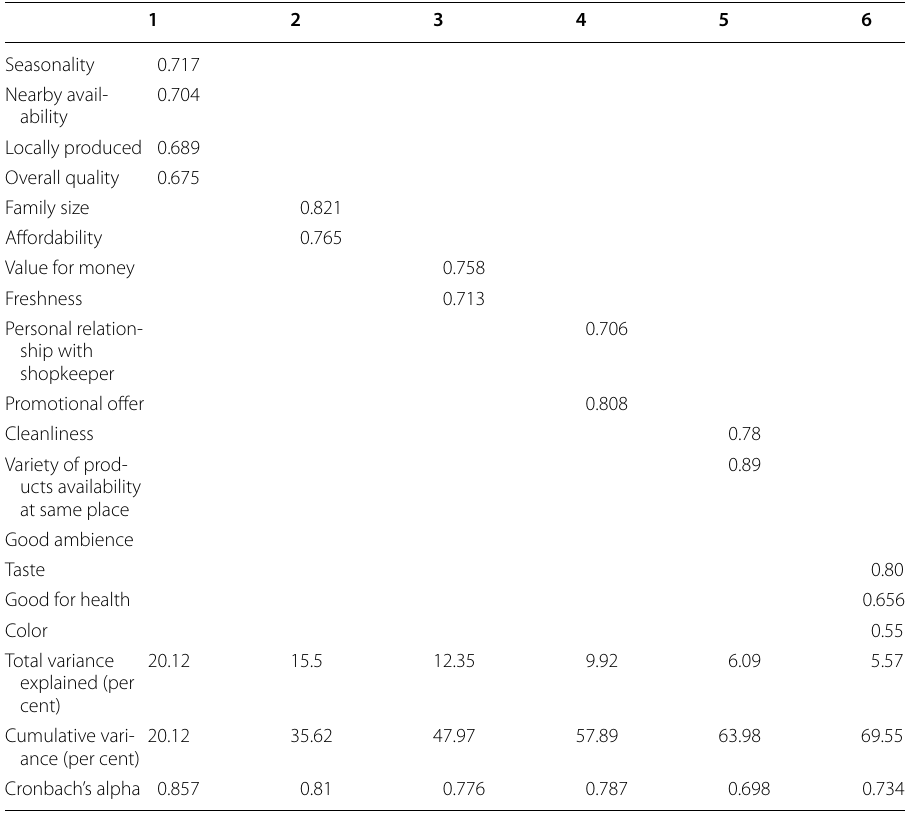
Extraction method: principal component analysis with varimax